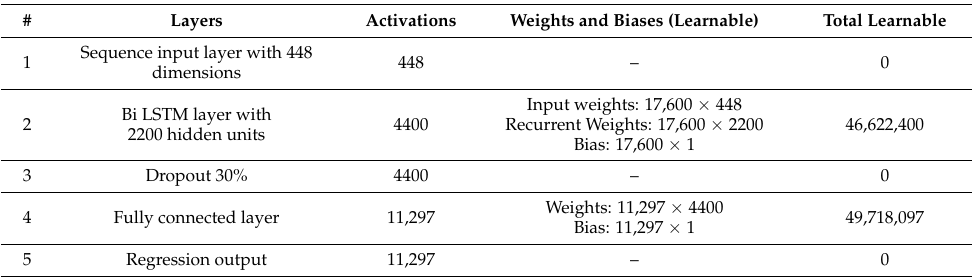
Table 3. Layers of the LSTM neural